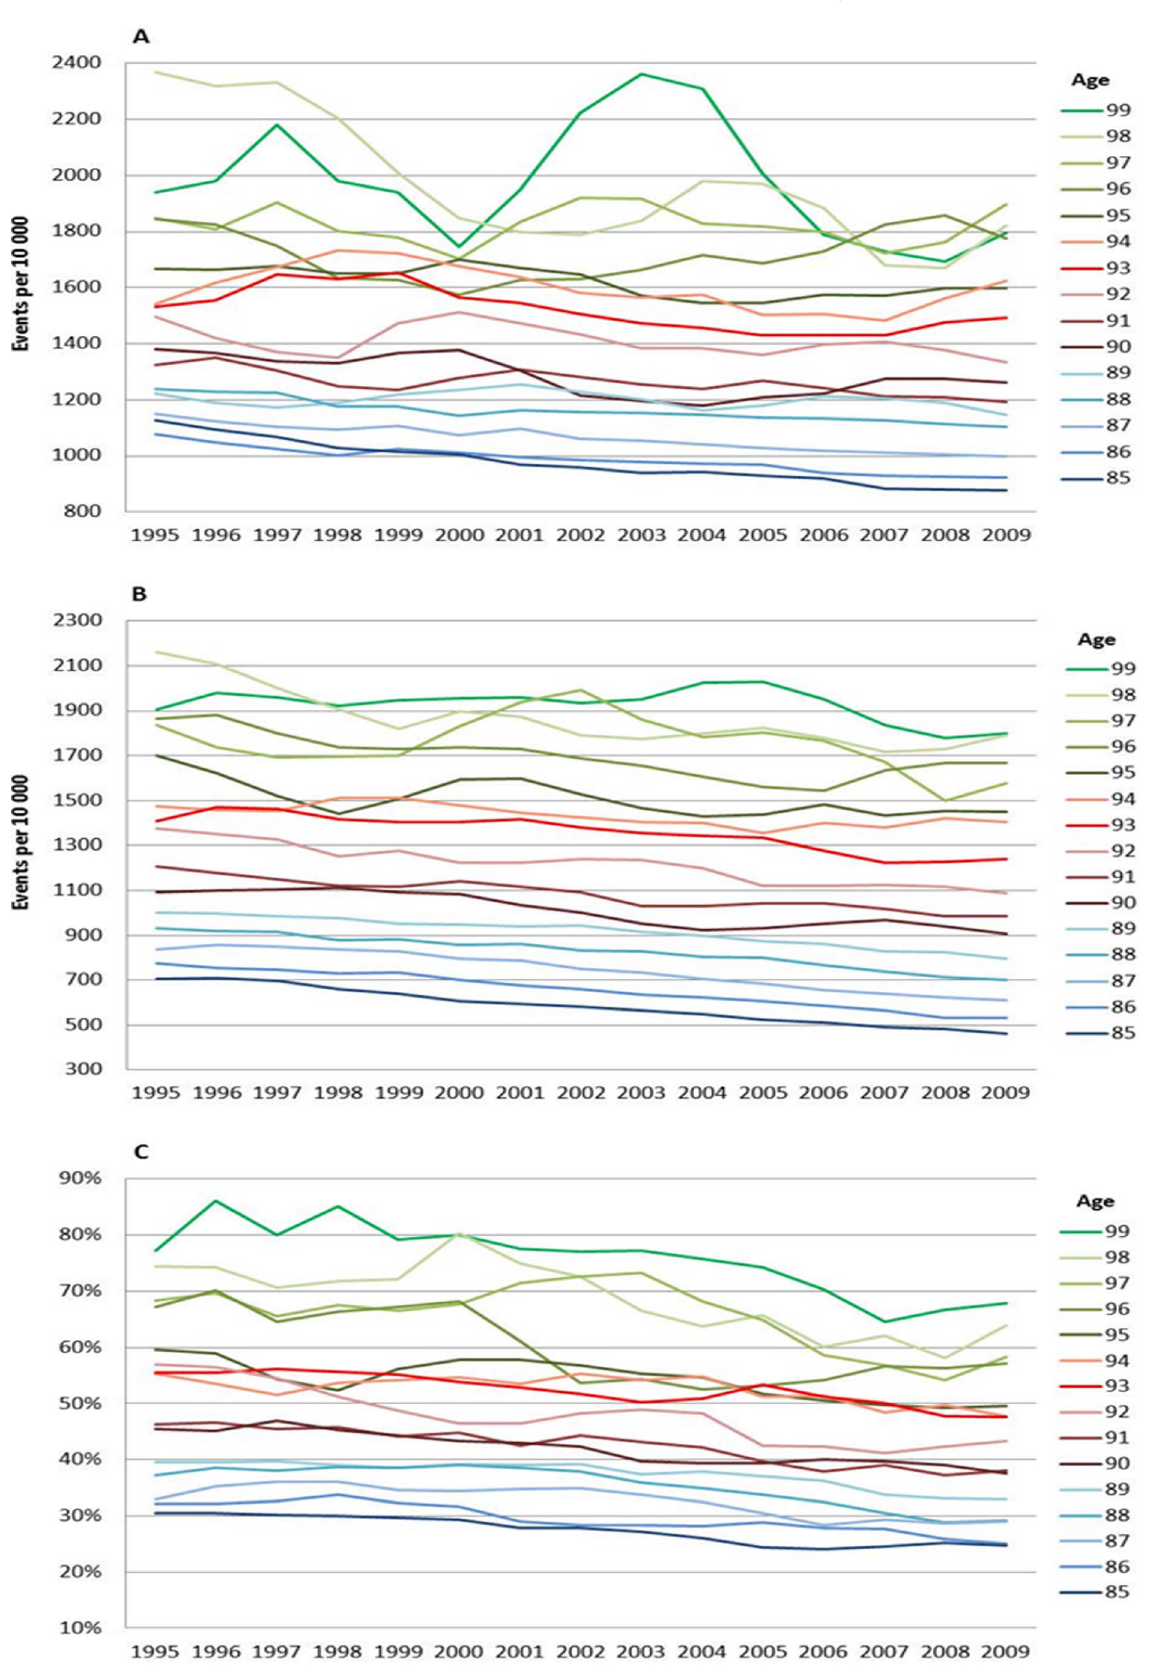
Figure 1. CVD incidence (A), mortality (B) and case fatality (C), men. Age specific trends in cardiovascular diseases, men, between 1994 and 2010. One year cumulative incidence (A), overall mortality (B), and, case fatality within 28 days, percent (C). Three year moving average. doi:10.1371/journal.pone.0064928.g001 PLOS ONE |